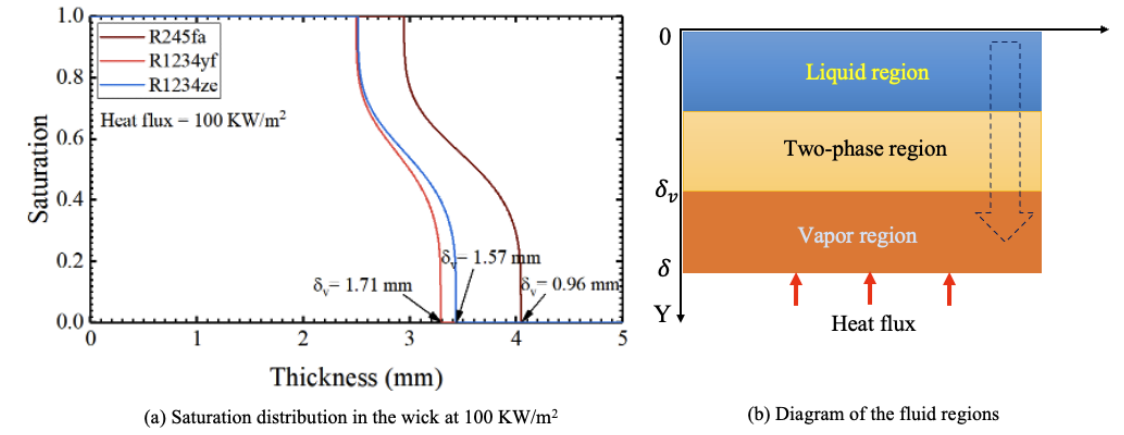
Figure 11. The saturation distribution within the wick and the subregions of fluids.